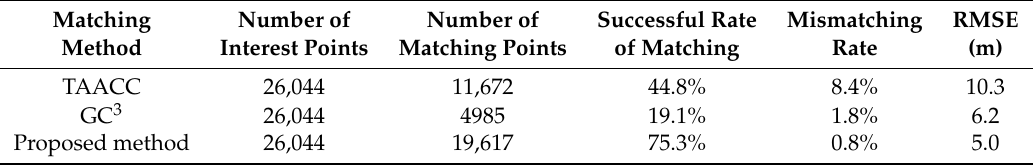
Table 3. Experimental results produced by TAACC, GC 3 and the proposed